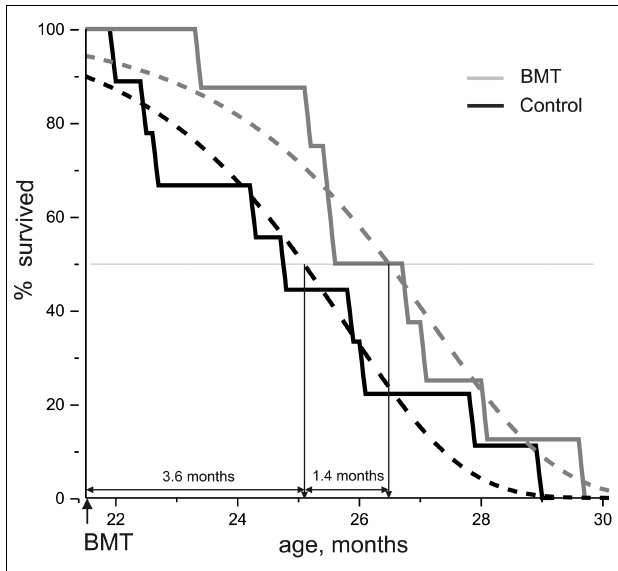
FIGURE 1 | Effect of massive non-myeloablating syngenic transplantation of bone marrow on the lifespan of C57BL/6 mice. Black line – Kaplan–Meier graph for animals from the control group ( solid line ) and its Gompertz approximation ( dashed line ); gray line – Kaplan–Meier graph for animals from the experimental group which underwent bone marrow transplantation ( solid line ) and its Gompertz approximation ( dashed line ). BMT, bone marrow